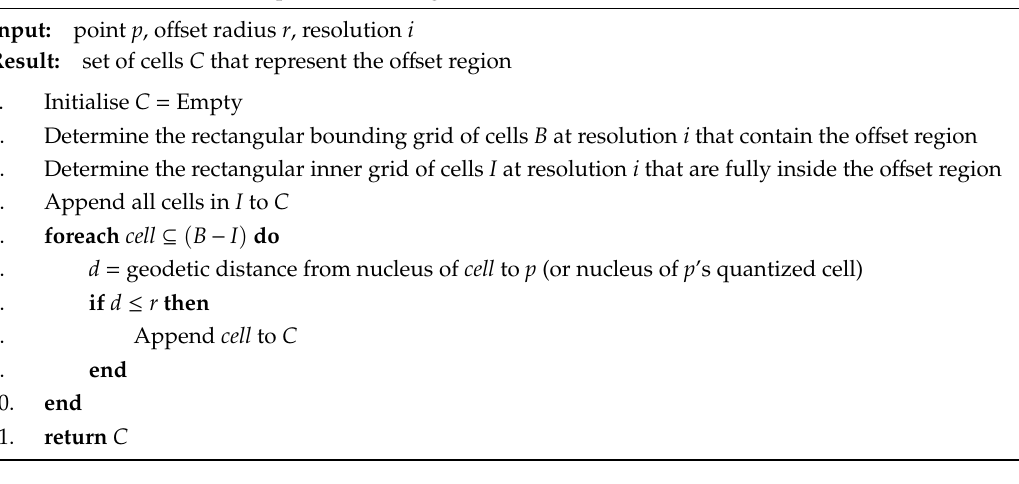
Algorithm 1 . Pseudocode to perform the single resolution